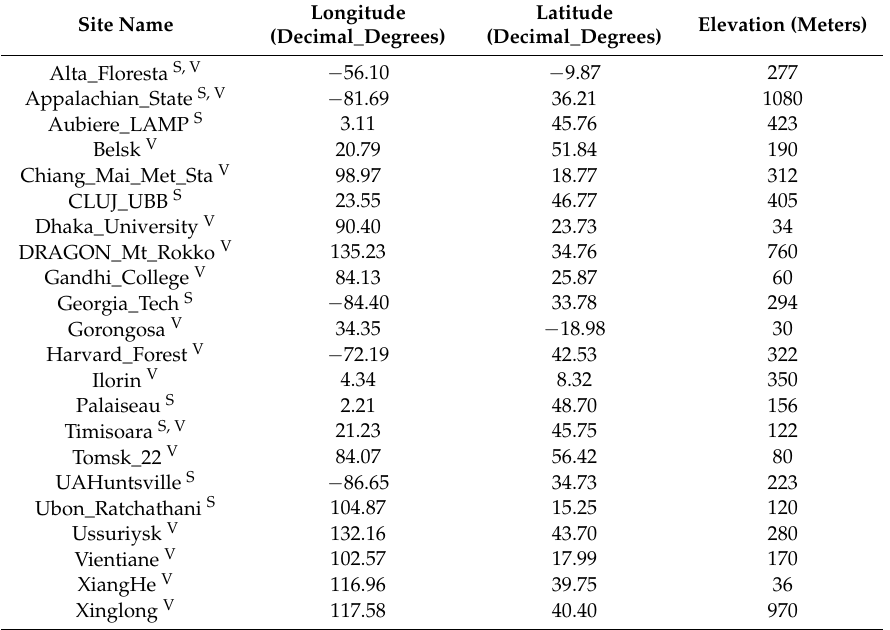
Table 1. The geographical information of AERONET sites ( S sites were used for studying reflectance relationships, V sites were used for validating results).